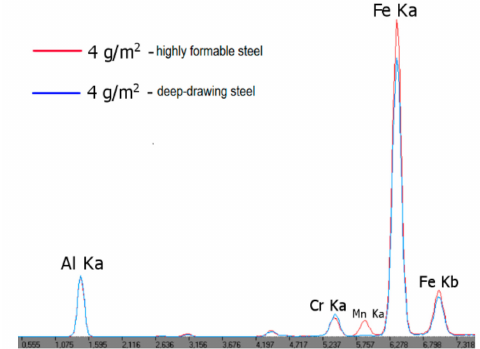
Figure 2. X-ray fluorescence (XRF) spectra of samples with Al coatings of the same thickness on di ff erent grades of steel.